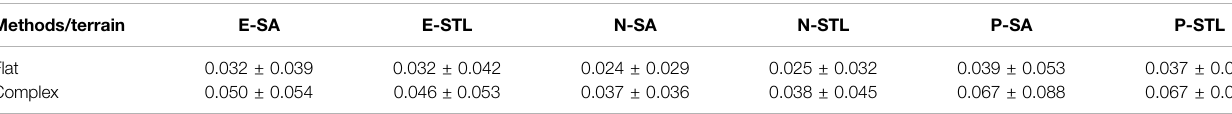
TABLE 5 | The means and standard deviations of SOS spatial CV for different terrains.